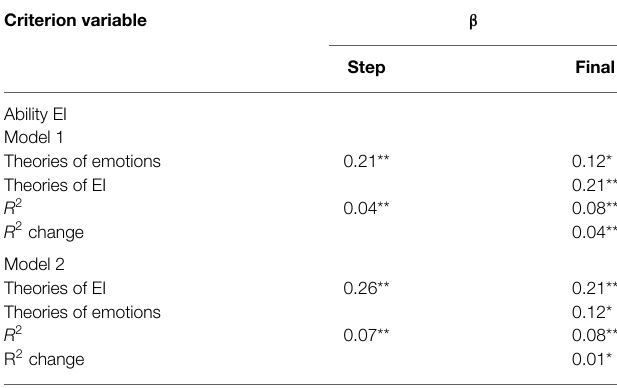
TABLE 2 | Regression to predict total ability EI from implicit theories of either emotion or EI. Criterion